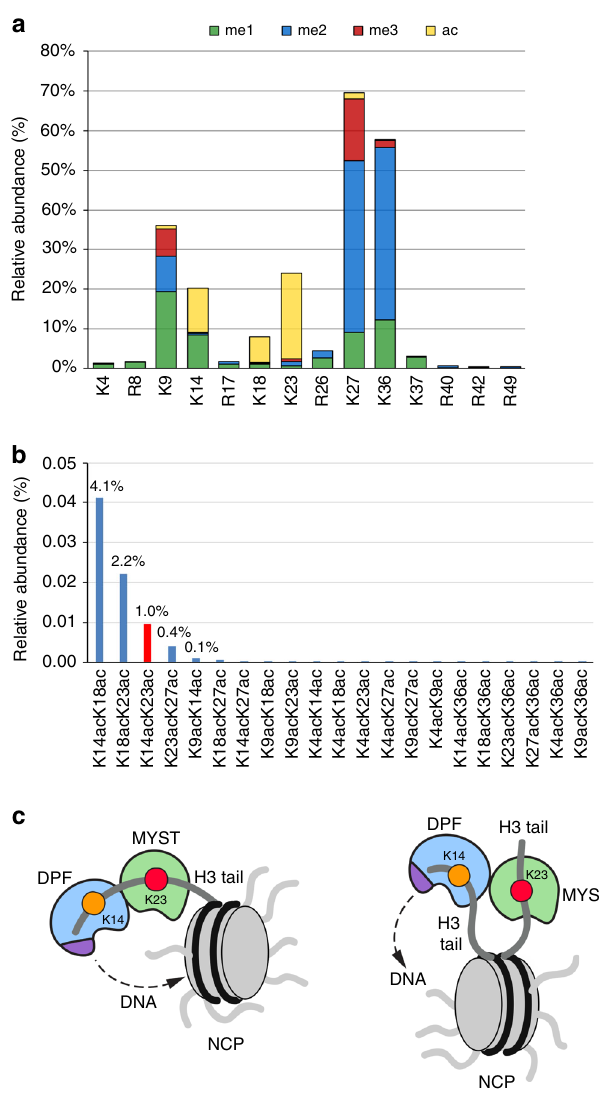
Fig. 8 H3K23ac and H3K14ac co-exist. a Relative abundance of single histone PTMs quanti fi ed on the histone H3.2/1 N-terminal tail (residues 1 – 50). Color coding represents different PTM type, and the y -axis represents the relative abundance; the percentage missing to 100% is the abundance of the unmodi fi ed state. b Relative abundance of binary histone PTMs on histone H3. The percentage represents the total relative abundance of histone tails containing the two acetylations listed in the x -axis. The relative abundance of H3K14acK23ac is highlighted in red. c Models for the association of MORF DPF-MYST in cis with a single H3 tail or in trans with two H3 tails of